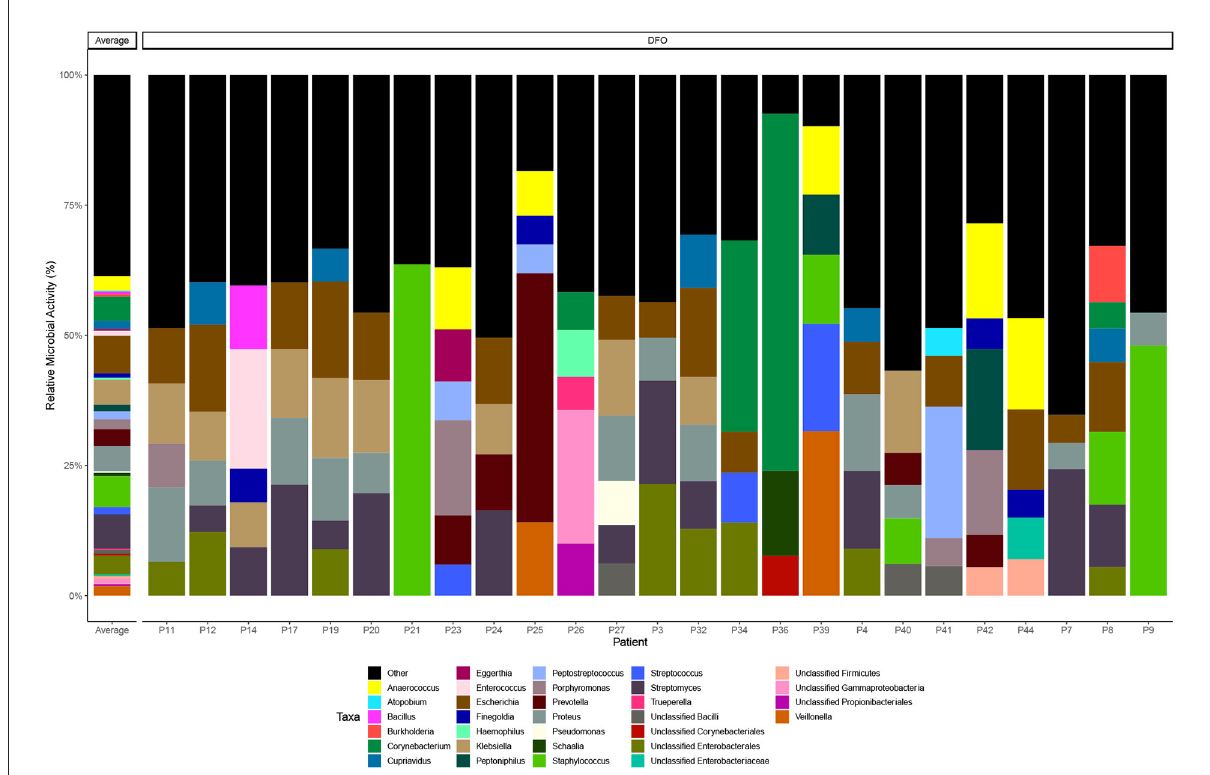
FIGURE1 Taxonomic distribution of microbial metatranscriptomic data. Bar chart highlighting taxonomy at the genus level that represent > 5% of overall microbial activity. Taxa below the 5% threshold are grouped as “other”.